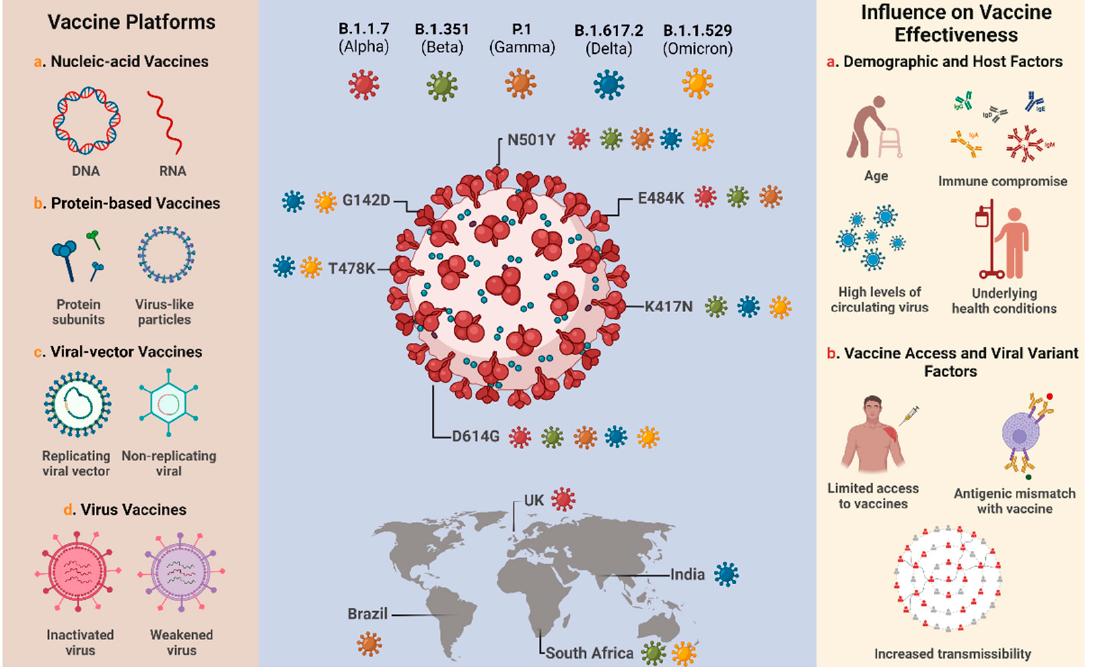
Figure 1. Overview of the major technology platforms used for COVID ‐ 19 vaccine development, the SARS ‐ CoV ‐ 2 variants of concern and their respective spike protein mutations, and the factors that may influence the effectiveness of available vaccines. Adapted from Tregoning et al. [44] and Mistry et al. [94]. Created with BioRender.com (accessed on 17 February 2022). Data provided by the CDC show that the number of cases and deaths caused by COVID-19 in the United States is higher among unvaccinated individuals when compared to individuals with a full primary vaccination scheme and/or those who have already